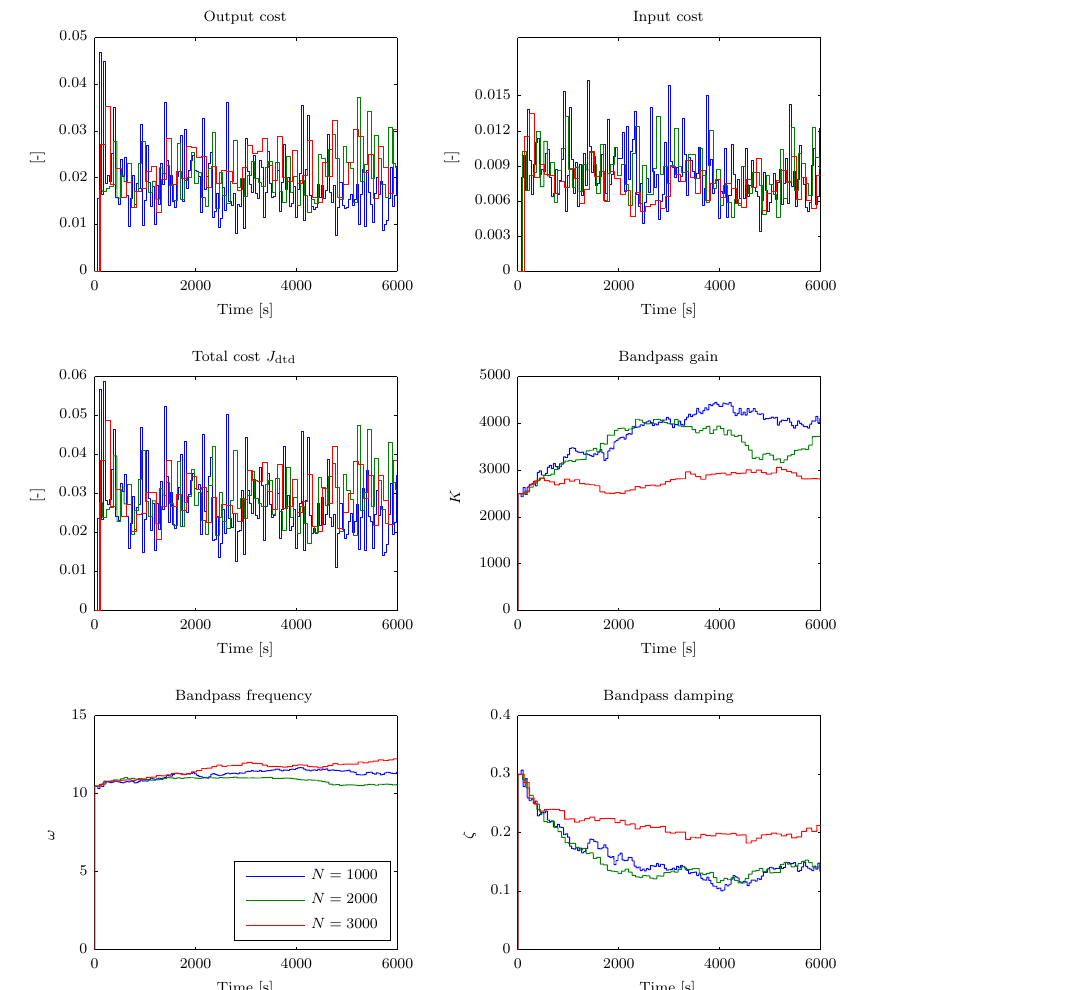
Figure 12. Comparison of IFT performance for different number N of collected data samples. Results shown are obtained with γ = 0 . 3, λ = 5 × 10 − 7 , F = 2000, and turbulent wind with mean speed 14ms − 1 and 10% turbulence intensity.